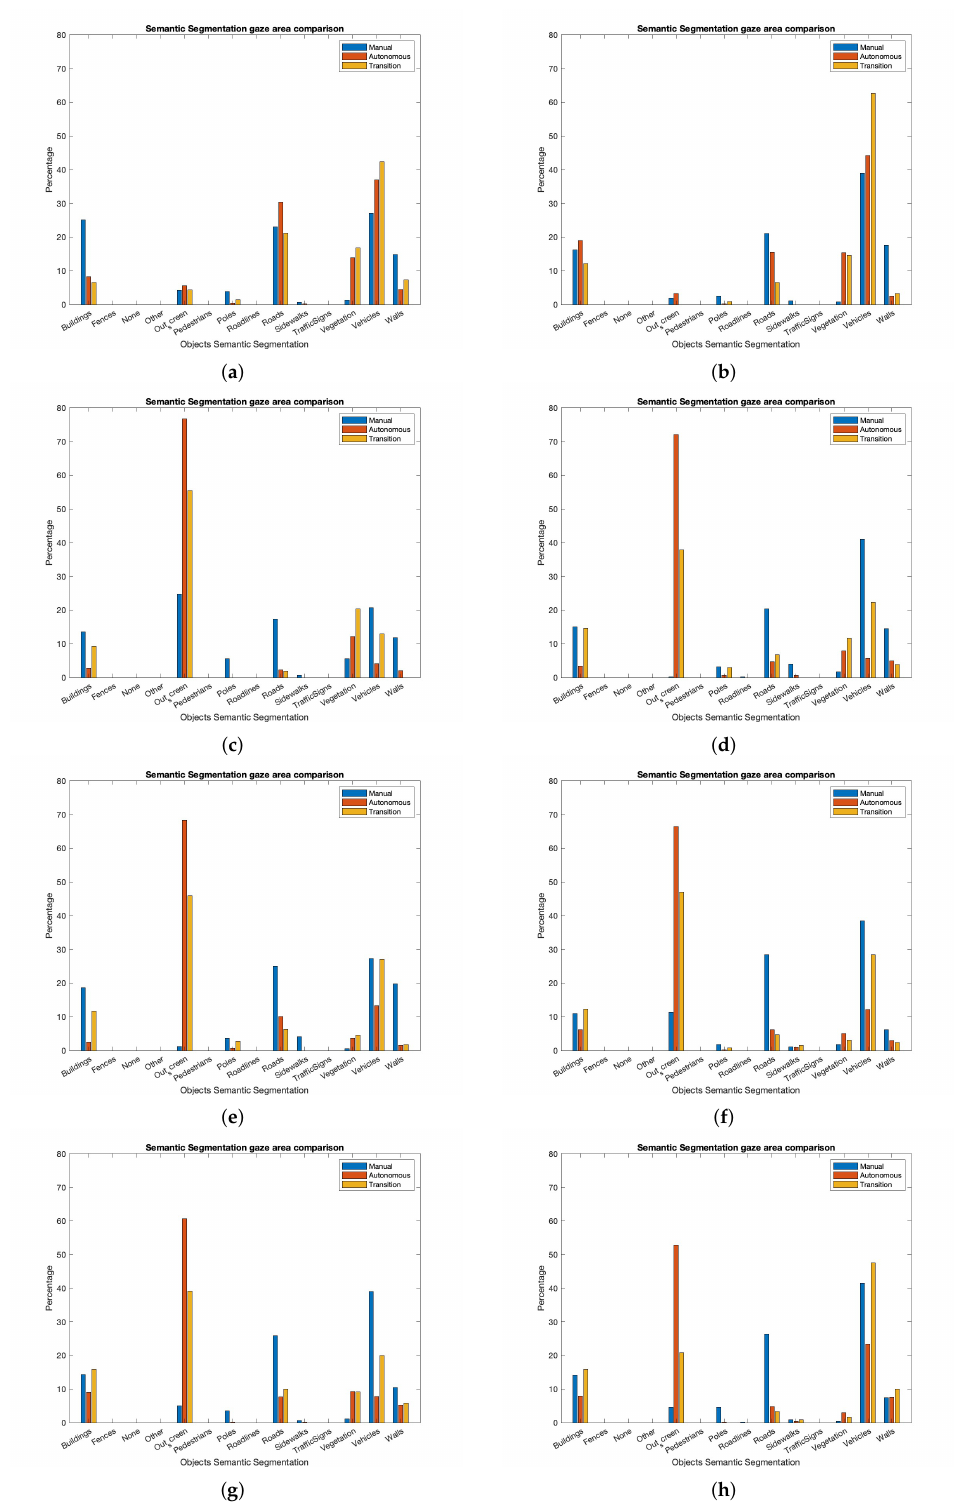
Figure 9. Gaze focalization analysis with semantic segmentation. ( a ) Experiment: ACC. Driver attention: focus. ( b ) Experiment: ACC + passing. Driver attention: focus. ( c ) Experiment: ACC. Driver attention: using the mobile phone. ( d ) Experiment: ACC + passing. Driver attention: using the mobile phone. ( e ) Experiment: ACC. Driver attention: reading. ( f ) Experiment: ACC + passing. Driver attention: reading. ( g ) Experiment: ACC. Driver attention: talking to passenger. ( h ) Experiment: ACC + passing. Driver attention: talking to